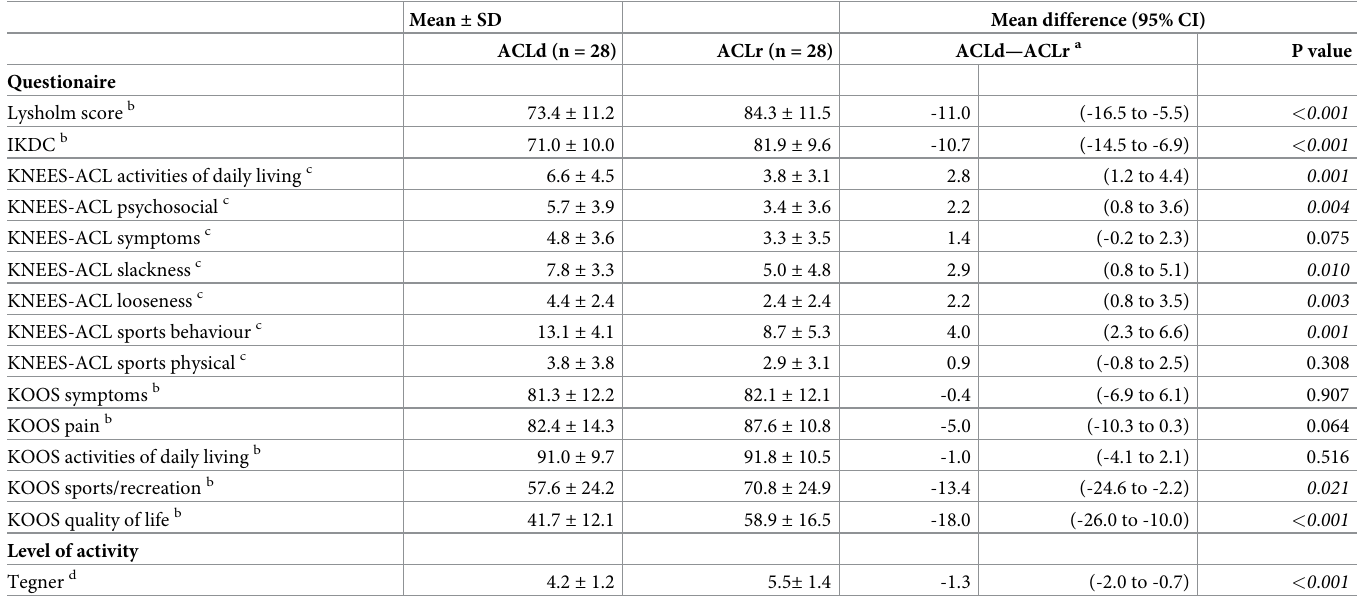
Table 4. Patient reported outcome measures and level of activity pre (ACLd) and post-surgery